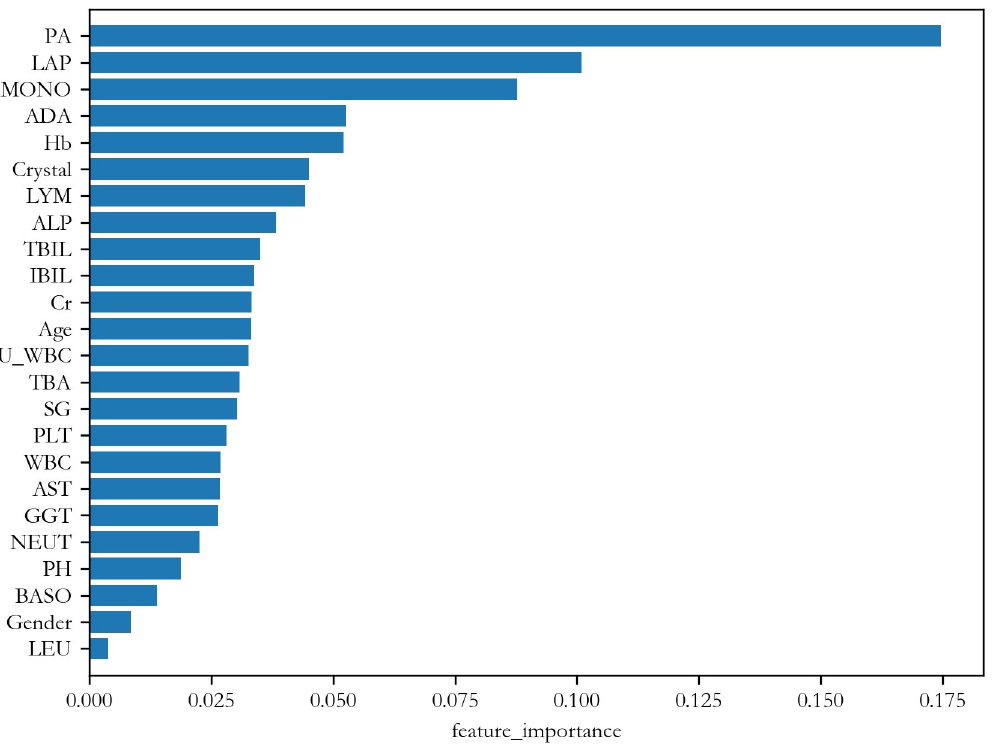
Fig 4. Feature importance ranking when classifying NPC vs. a mixture of 50% CRS and 50% controls.